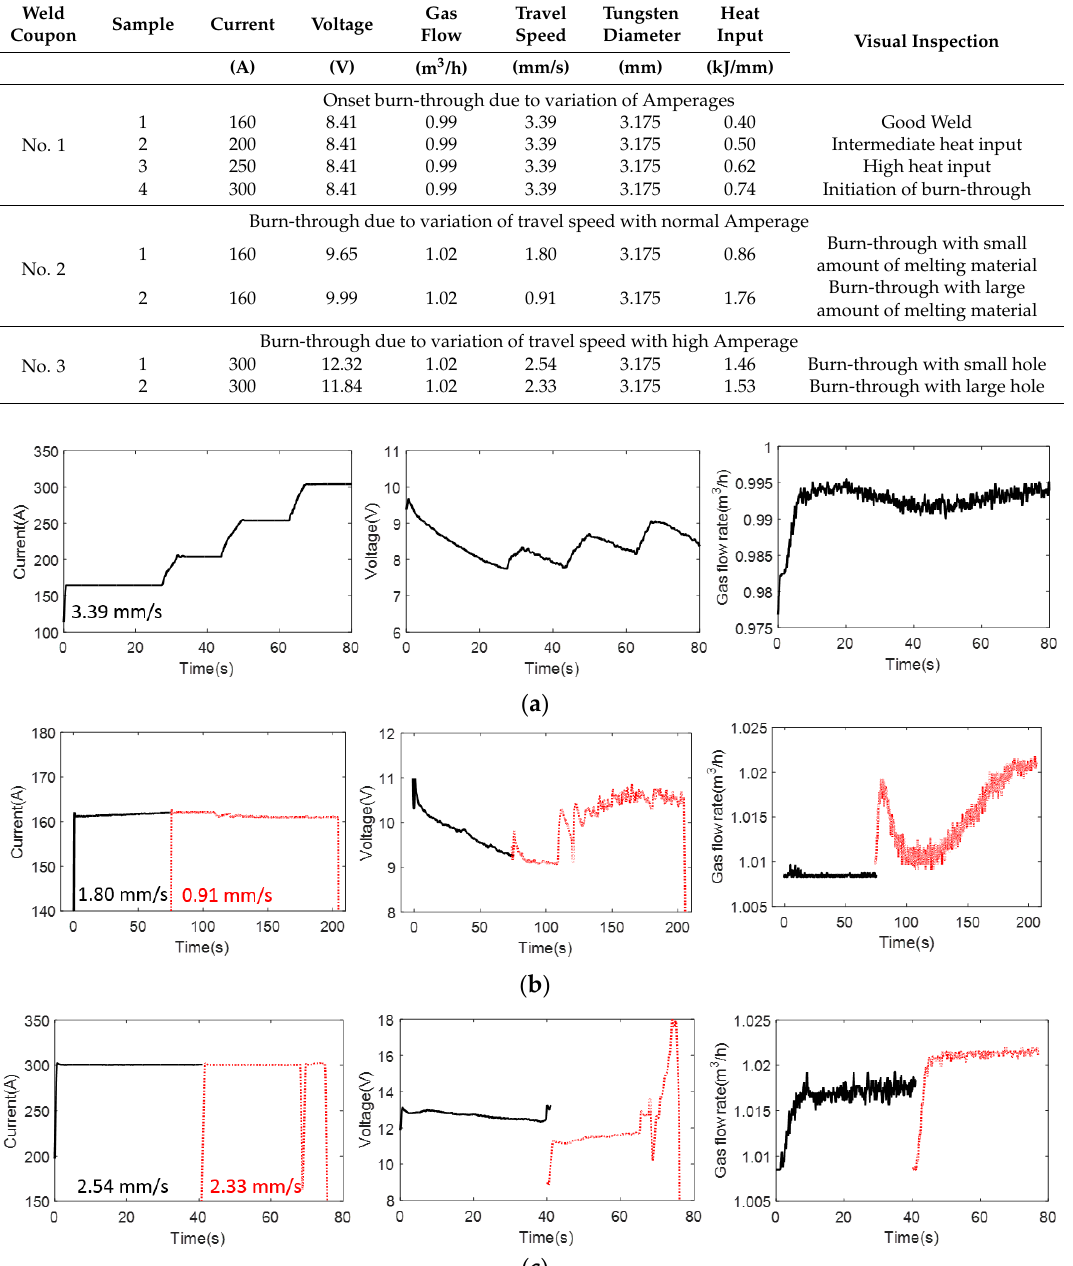
Table 2. Different changes of Amperages and travel speed to obtain burn-through.